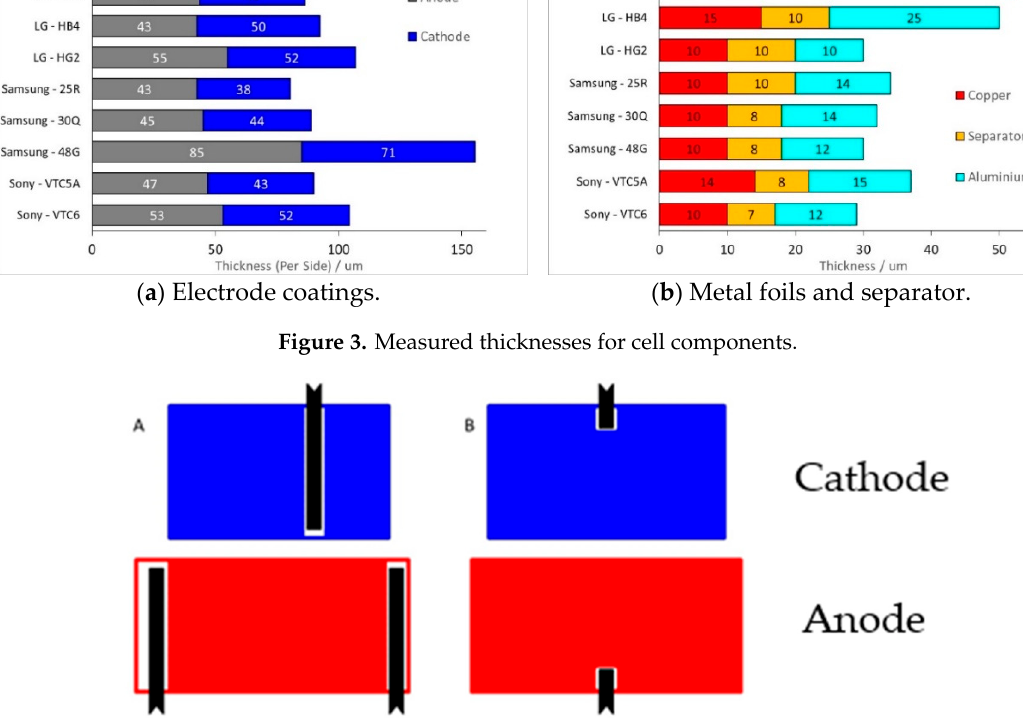
Figure 4. Tag arrangements in cylindrical cells ( A ) Eight cells ( B ) 123 18650 M1A.